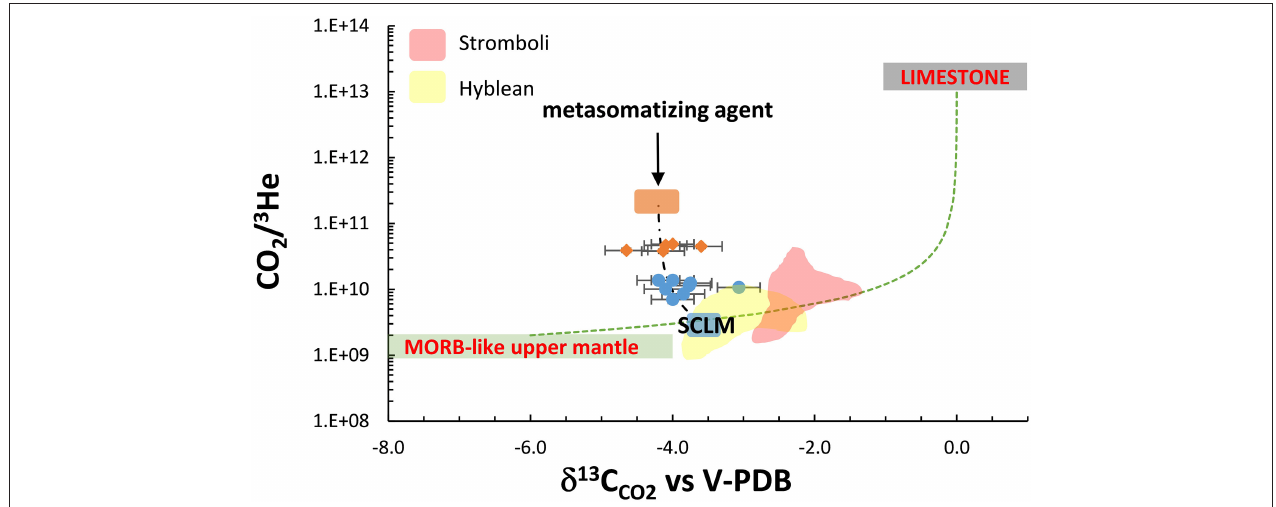
FIGURE 12 | C-isotope composition ( δ 13 C) vs. CO 2 / 3 He. The green, blue, orange, and gray rectangles are the same as in Figures 7 , 10 . Data from the Hyblean Plateau and Stromboli are from Correale et al. (2015) and Gennaro et al. (2017), respectively. The green dotted curve represents the binary mixing between a MORB-like upper mantle having δ 13 C = − 6 ‰ and CO 2 / 3 He = 2 × 10 9 , and limestone having δ 13 C = 0 ‰ and CO 2 / 3 He = 1 × 10 13 (Marty and Jambon, 1987; Javoy and Pineau, 1991; Sano and Marty, 1995). The black dotted line represents binary mixing between two endmembers: (1) the residual mantle (blue rectangle) having CO 2 / 3 He = 4.8 × 10 9 and δ 13 C = − 3.5 ‰ , and (2) the metasomatic agent (orange rectangle) having CO 2 / 3 He = 2.4 × 10 11 and δ 13 C = − 4 ‰ . The symbols are the same as in Figure 5 .